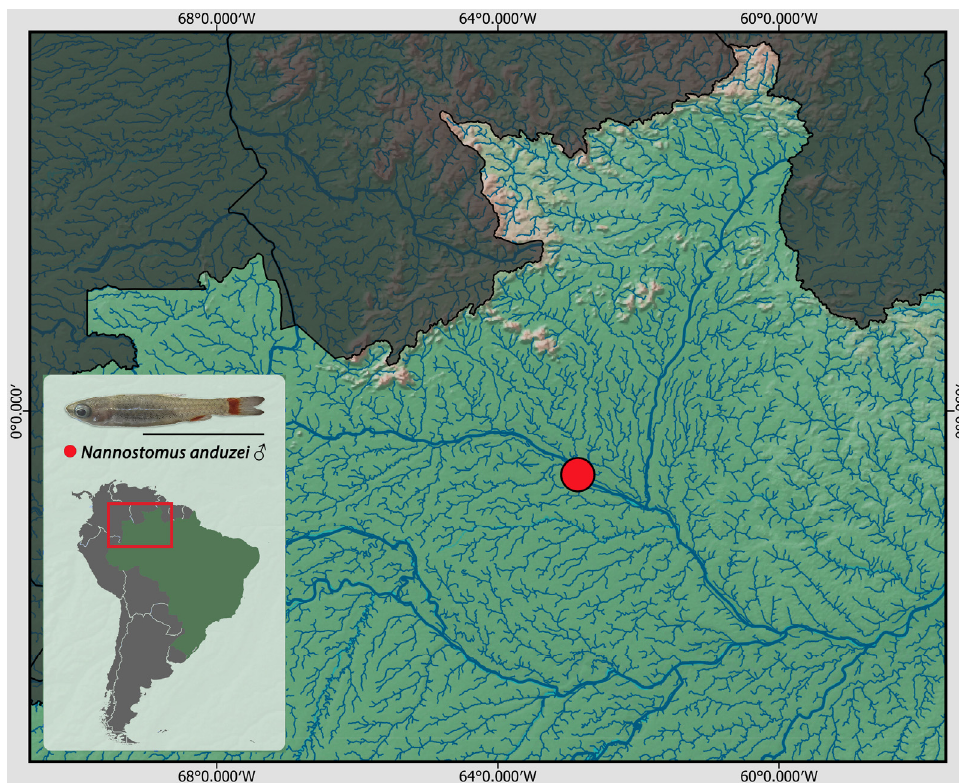
Figure 1. Collection site of N. anduzei in Barcelos—AM. Scale bar equals 1